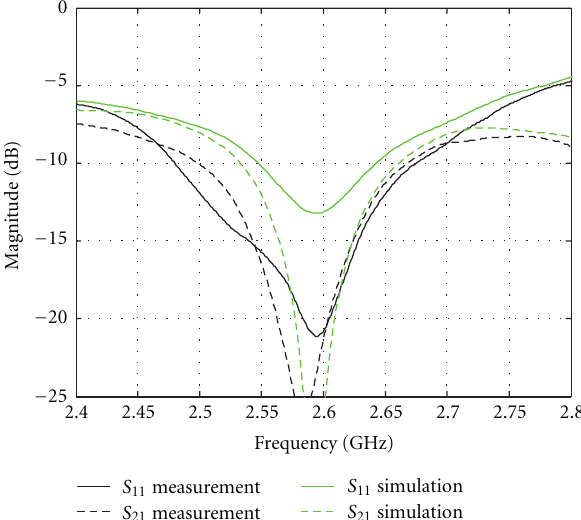
Figure 6: S -parameters for the optimized structure of the MIMO antenna system #1 (measurements versus simulations).